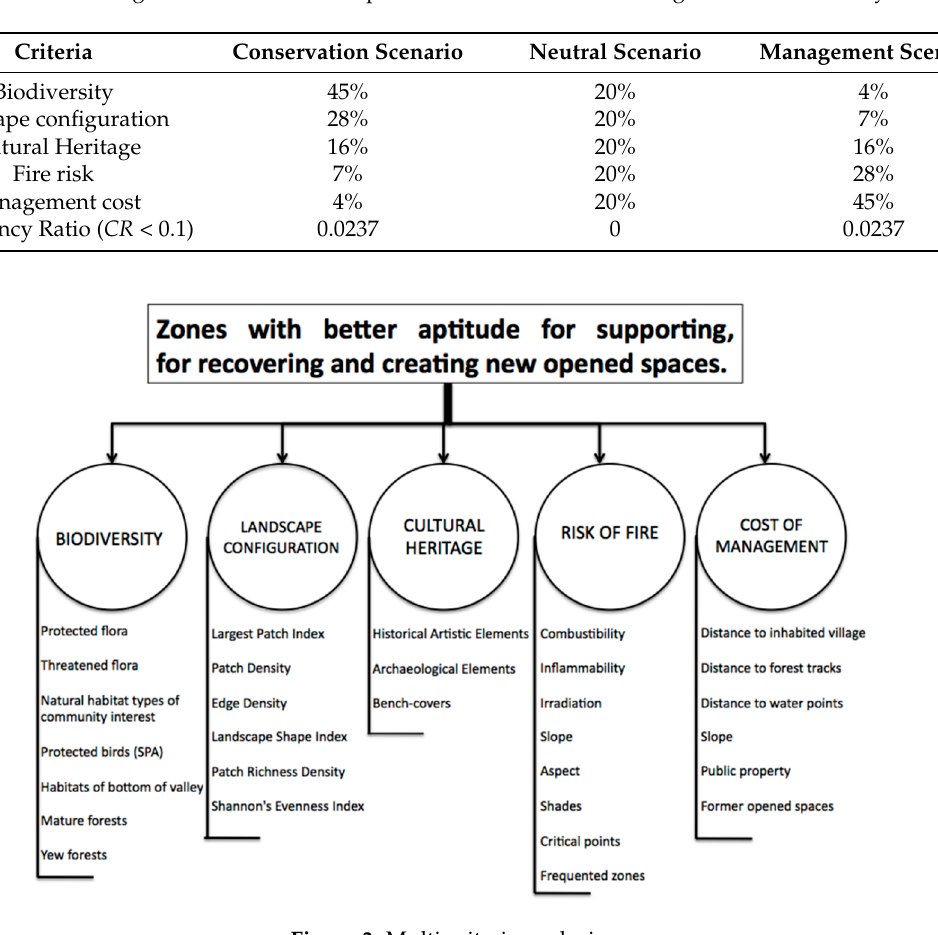
Figure 3. Multi-criteria analysis.